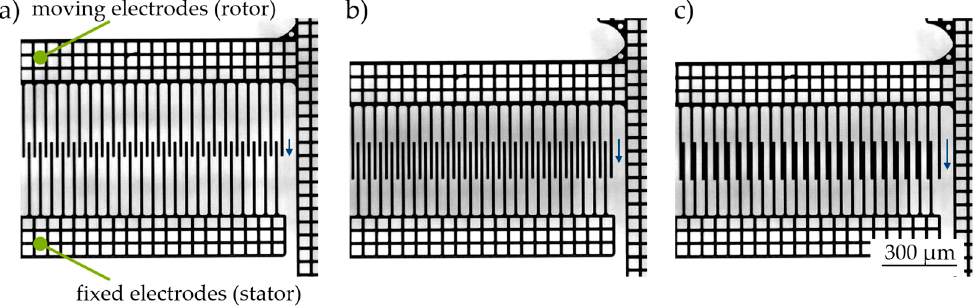
Figure 5. Experimental voltage-dependent displacement of a comb-drive actuator ( a ) after applying a voltage, ( b ) further increase in the voltage and displacement, ( c ) sudden pull-in due to lateral instability.